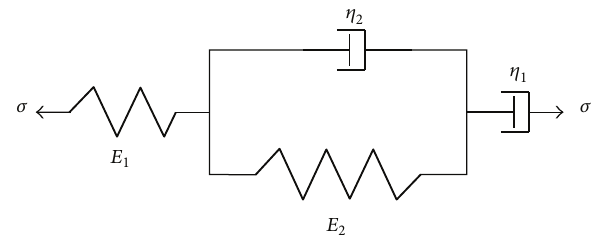
Figure 3: Schematic diagram of Burgers model.